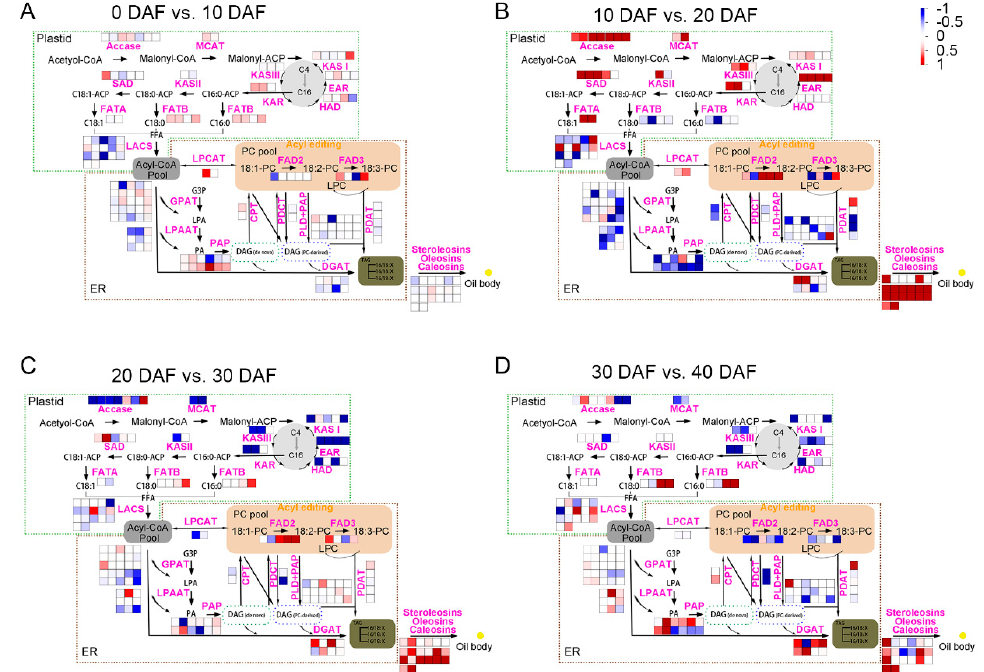
Figure 3. Mapman visualization of differentially expressed genes in the lipid metabolic pathways between the adjacent developmental stages in soybean seeds. ( A ) 0 DAF vs. 10 DAF. ( B ) 10 DAF vs. 20 DAF. ( C ) 20 DAF vs. 30 DAF. ( D ) 30 DAF vs. 40 DAF. Every square represents a gene. The